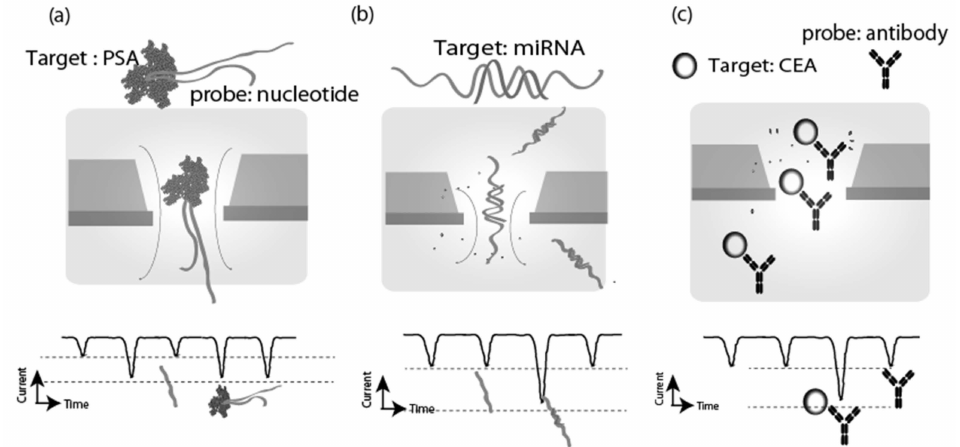
Figure 3. Indirect sensing of target molecule/particle by nanodevices. In this sensing mode, a probe molecule that selectively binds to the target molecule is required. DNA aptamer ( a ) and complemen- tary nucleotides ( b ) are used as probe molecules. In addition to nucleotide probe molecules, peptide chains and monoclonal antibodies ( c ) are used to measure the binding form of target molecules and particles using nanodevices, and identify the differences in electrical signals.